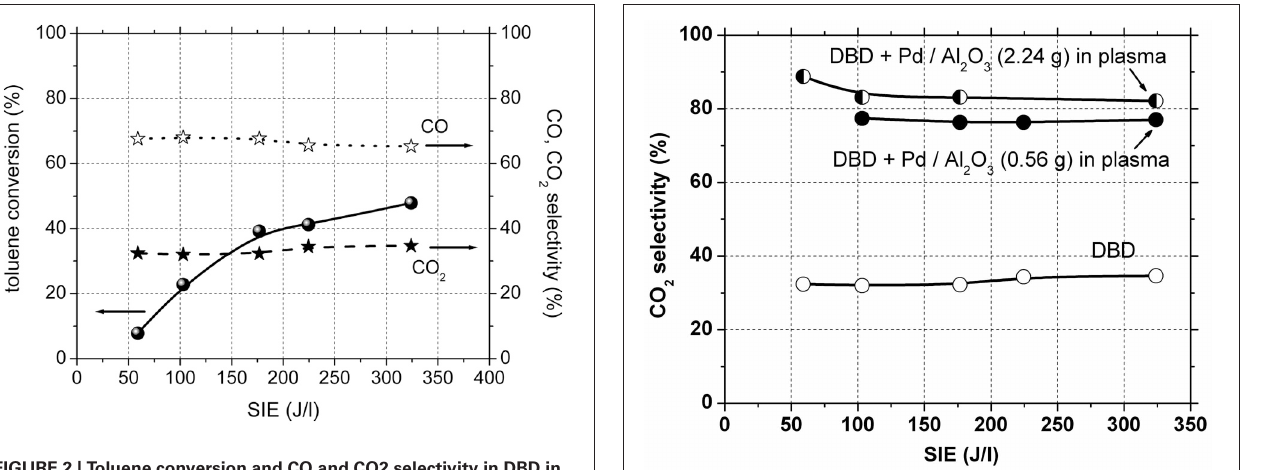
FIGURE 2 | Toluene conversion and CO and CO2 selectivity in DBD in the absence of catalysts.